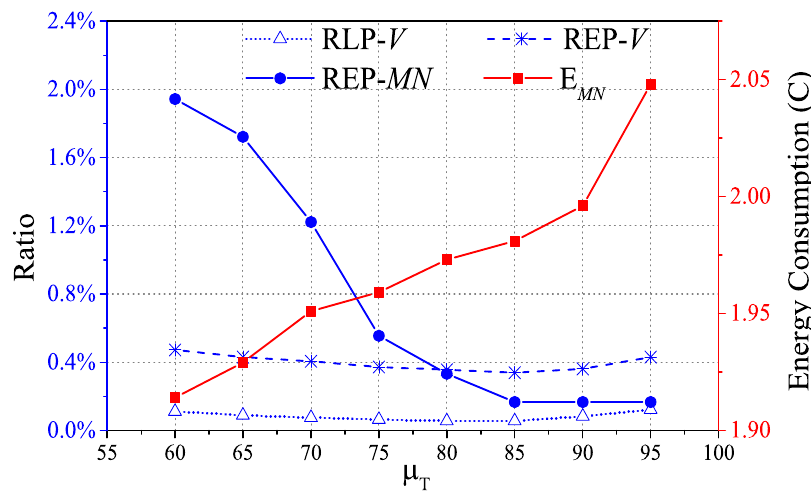
Figure 11. RLP- V , REP- V , REP- MN and energy consumption of mobile node with variation of µ T